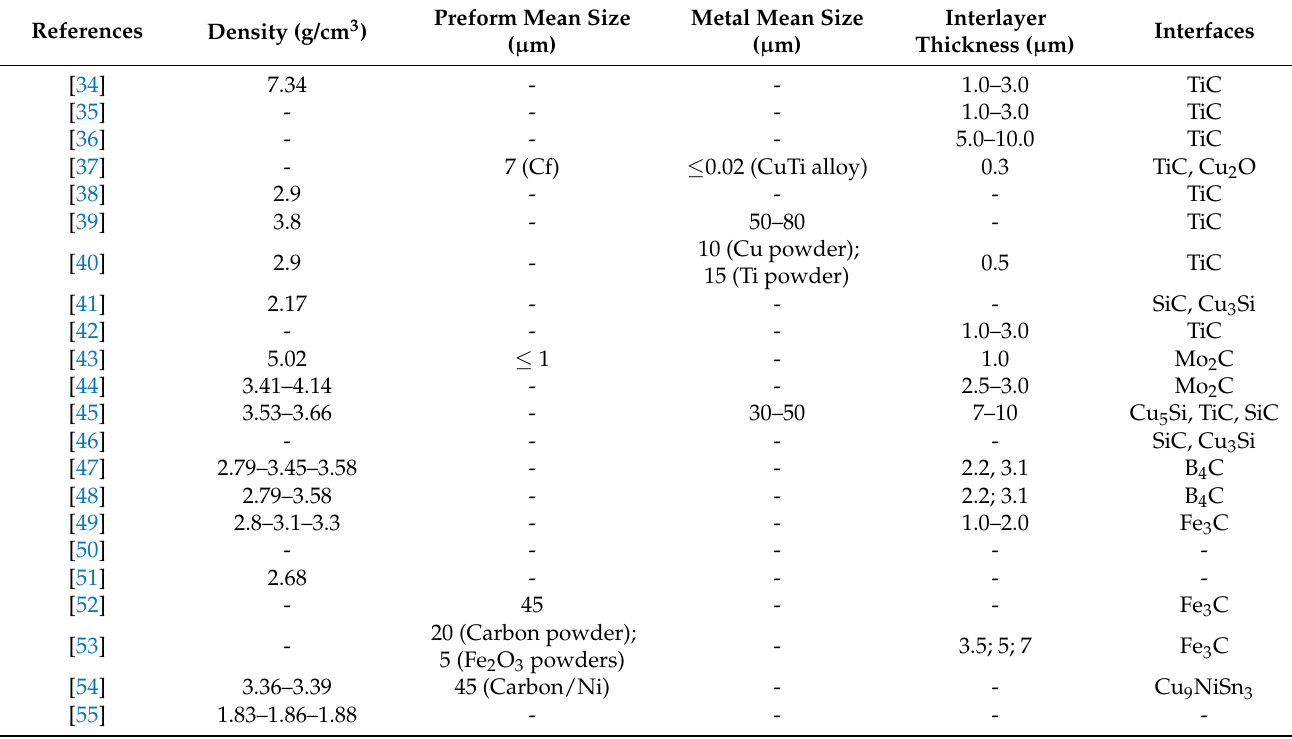
Table 3. Physical properties and microstructure of